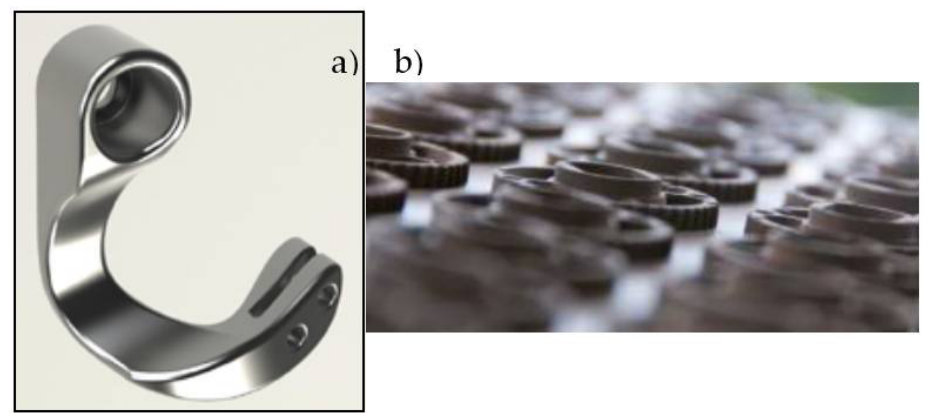
Figure 2. Titanium bicycle components produced using MIM, ( a ) derailleur component produced by Element22 GmbH. Germany (Image PIM International, Vol. 6 No. 2, 2012), ( b ) bicycle gears produced by Mimest SpA, Italy (PIM International Vol. 4 No. 3, 2010).